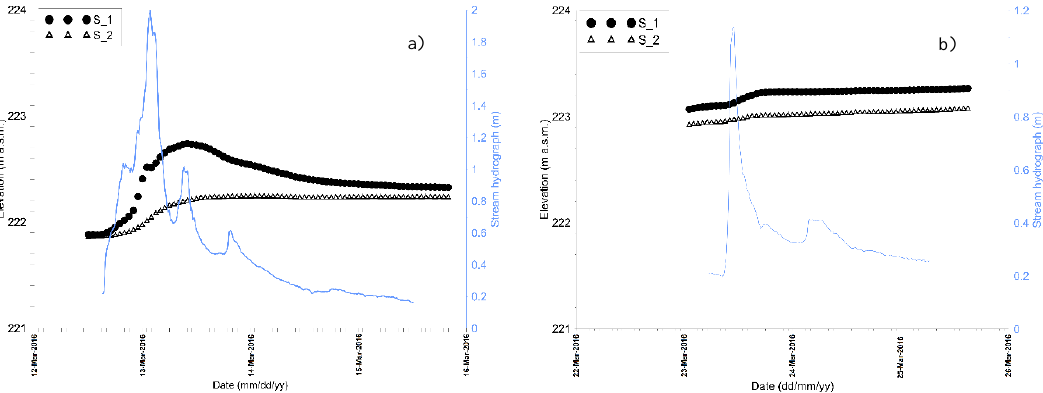
Figure 12. Stream hydrograph during the flood event of ( a ) 13 March 2016 and of ( b ) 23 March 2016 compared with groundwater level time series recorded in the piezometers S1 and S2.